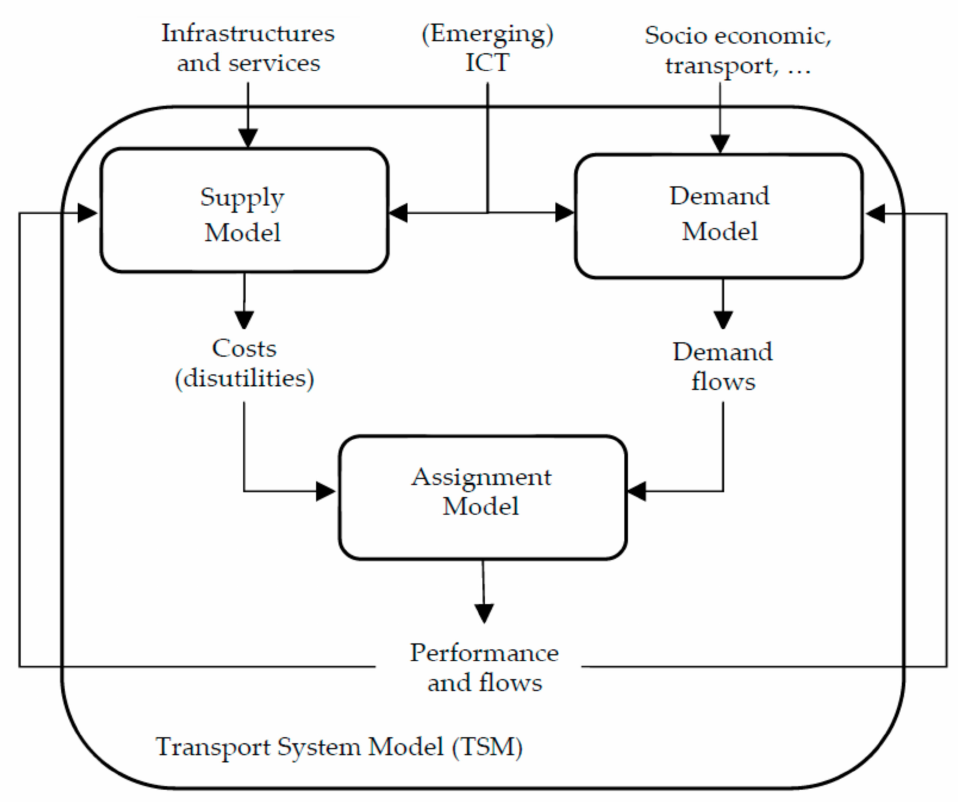
Figure 2. Inputs-outputs, components and interactions of